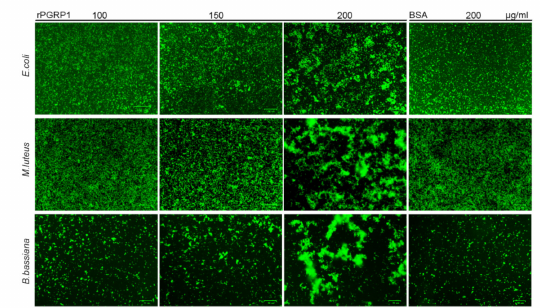
Figure 5. Agglutination of microorganisms by recombinant PGRP1. Different concentrations of recombinant PGRP1 (100 µ g/mL, 150 µ g/mL, and 200 µ g/mL) were incubated with acridine orange- stained E. coli (2 × 10 8 cells/mL), M. luteus (2 × 10 8 cells/mL), or B. bassiana (1 × 10 5 conidia/mL), respectively, in PBS for 45 min at room temperature. BSA (200 µ g/mL) instead of rPGRP1 was used as a control. The agglutination of microbial cells was then observed under invert fluorescence microscopy.